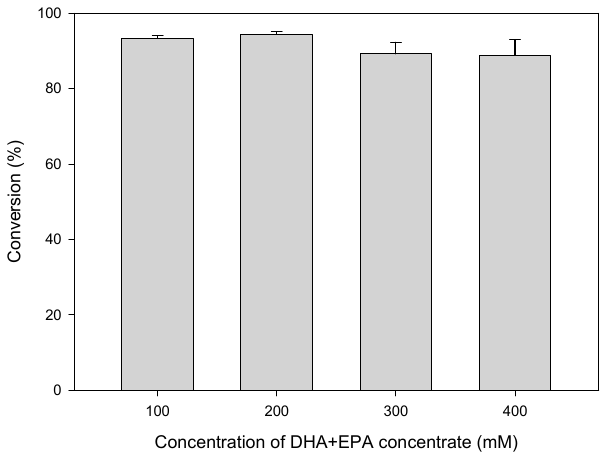
Figure 4. E ff ect of concentration of DHA + EPA concentrate on the conversion of DHA + EPA ethyl ester Figure 4. Effect of concentration of DHA+EPA concentrate on the conversion of DHA+EPA ethyl ester at a substrate ratio of 1:1 (DHA + EPA: EA), temperature of 60 ◦ C, and enzyme activity of 200 at a substrate ratio of 1:1 (DHA+EPA: EA), temperature of 60 °C, and enzyme activity of 200 U.